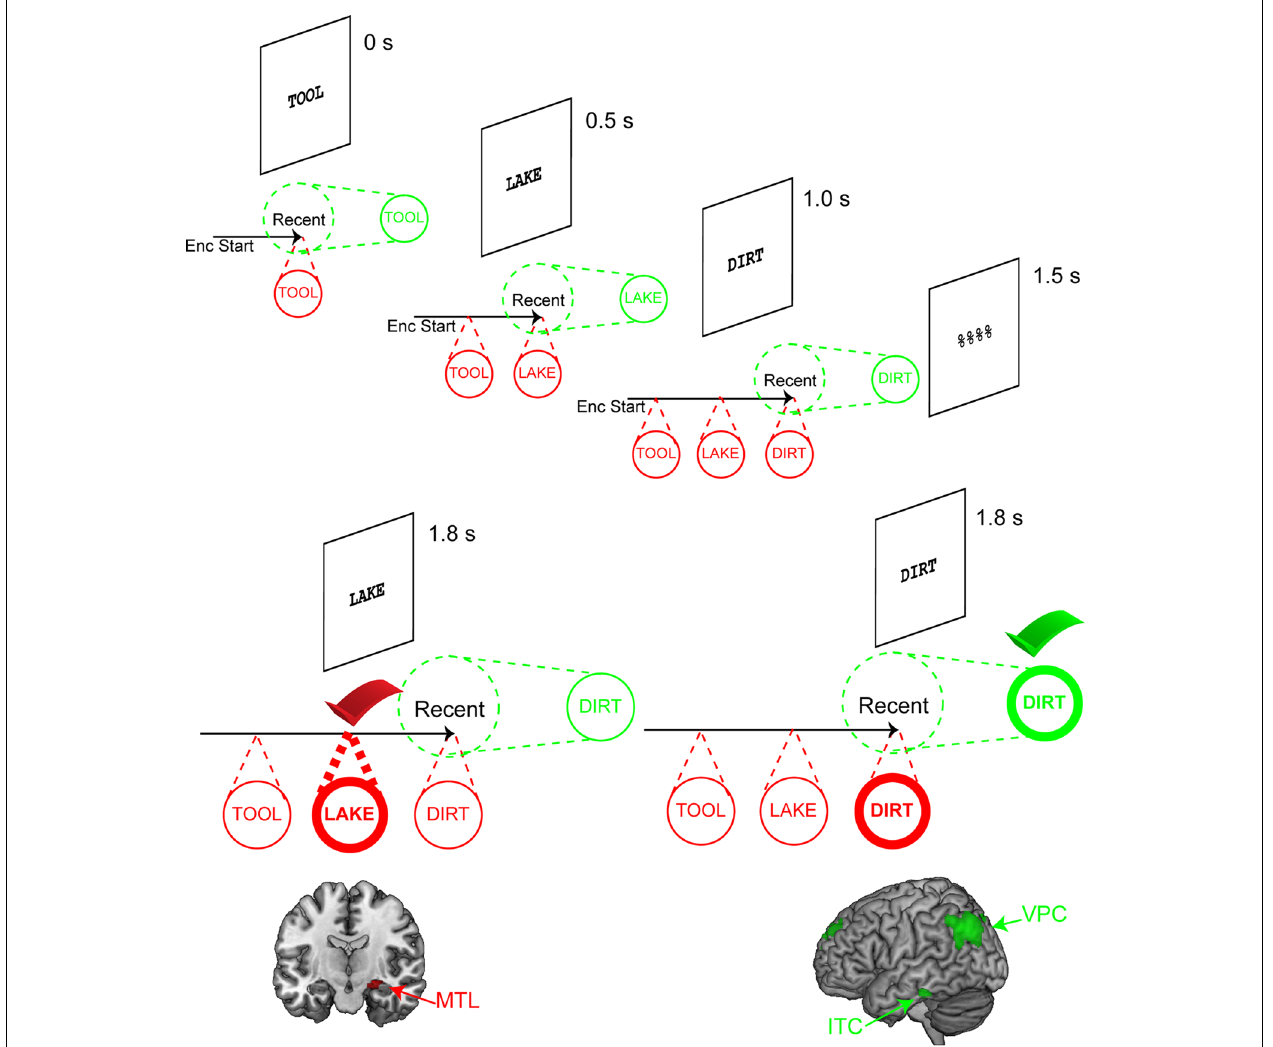
Two kinds of probes are depicted.The left depicts a scenario where “LAKE” is the probe.This activates its corresponding representation.The bindings to the trial context, maintained by the direct-access region, verify that “LAKE” is an old probe resulting in a match decision.This elicits activation in the medial temporal lobe (MTL).The right depicts an alternative scenario where “DIRT” is the probe. Once again, “DIRT” activates its corresponding representation. In this case, however, “DIRT” is the focus of attention, so it can be verified immediately without the need to retrieve contextual information.This elicits activation in inferior temporal cortex (ITC) and ventral parietal cortex (VPC). Activation data adapted from Nee and Jonides